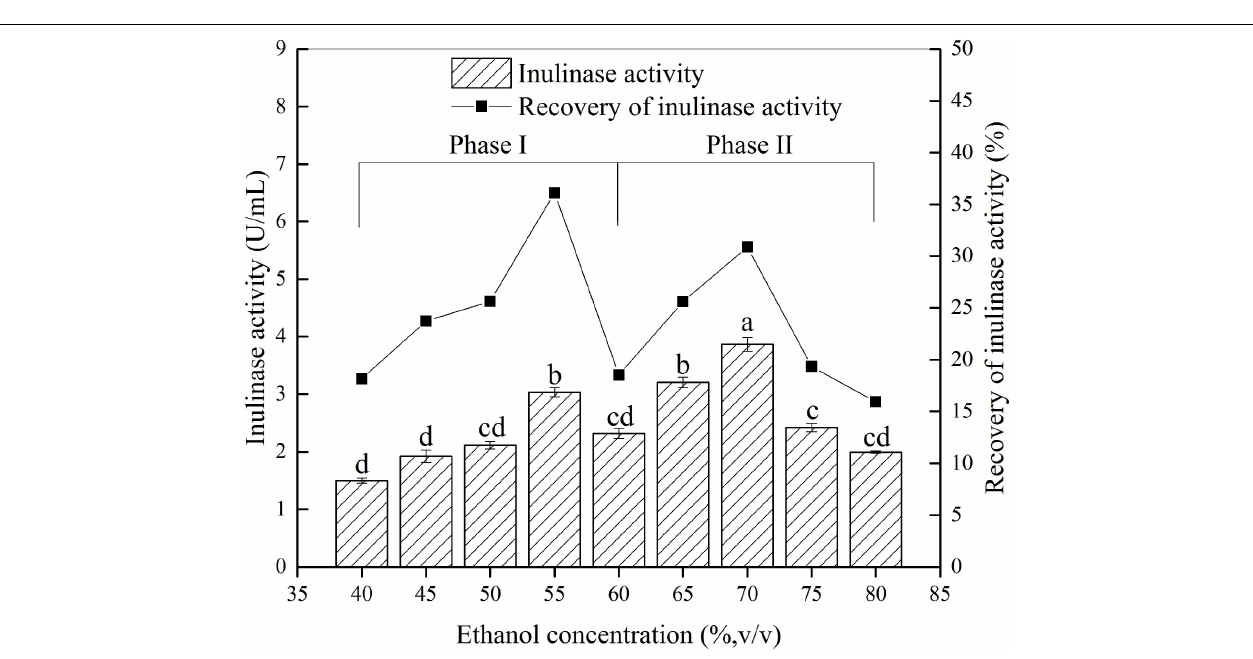
FIGURE 2 | The inulin-mediated ethanol gradient precipitation of natural inulinase from Aspergillus niger. The conditions of the inulin-ethanol precipitation were as follows: 40 g/L inulin, 0 ◦ C and pH 4.6. Lower case letters: Significant differences ( p < 0.05). Statistical analysis was performed using a one-way ANOVA with Tukey’s